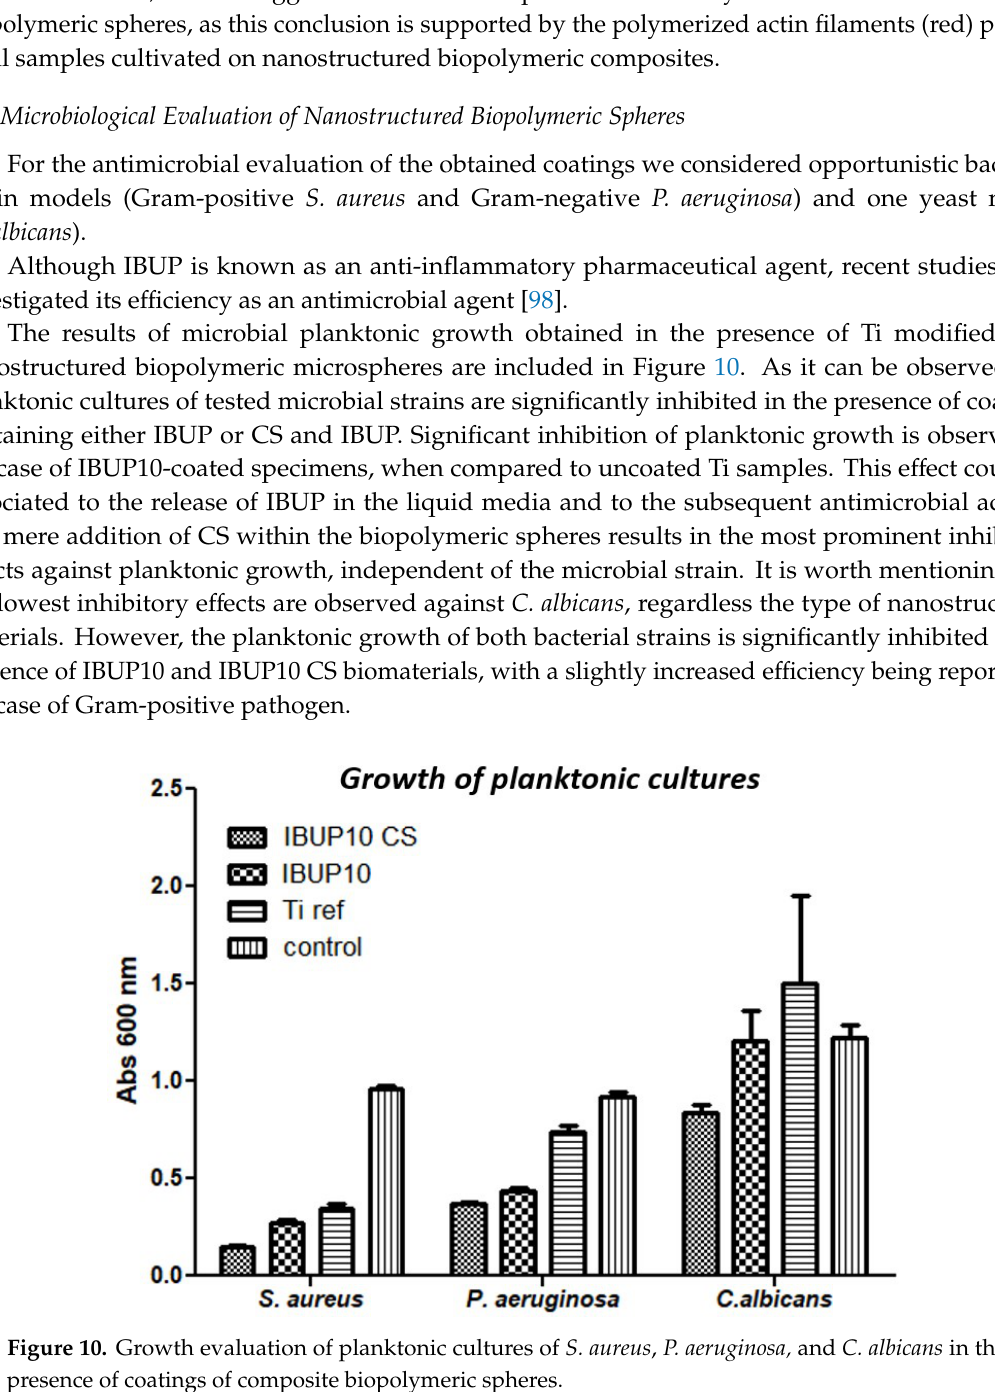
Figure 9. Adhesion and distribution of differentiated THP-1 cells on coatings of composite biopolymeric spheres. Representative images of the attached cells obtained by fluorescence microscopy (40×) by marking actin filaments (red) and nuclei (blue).